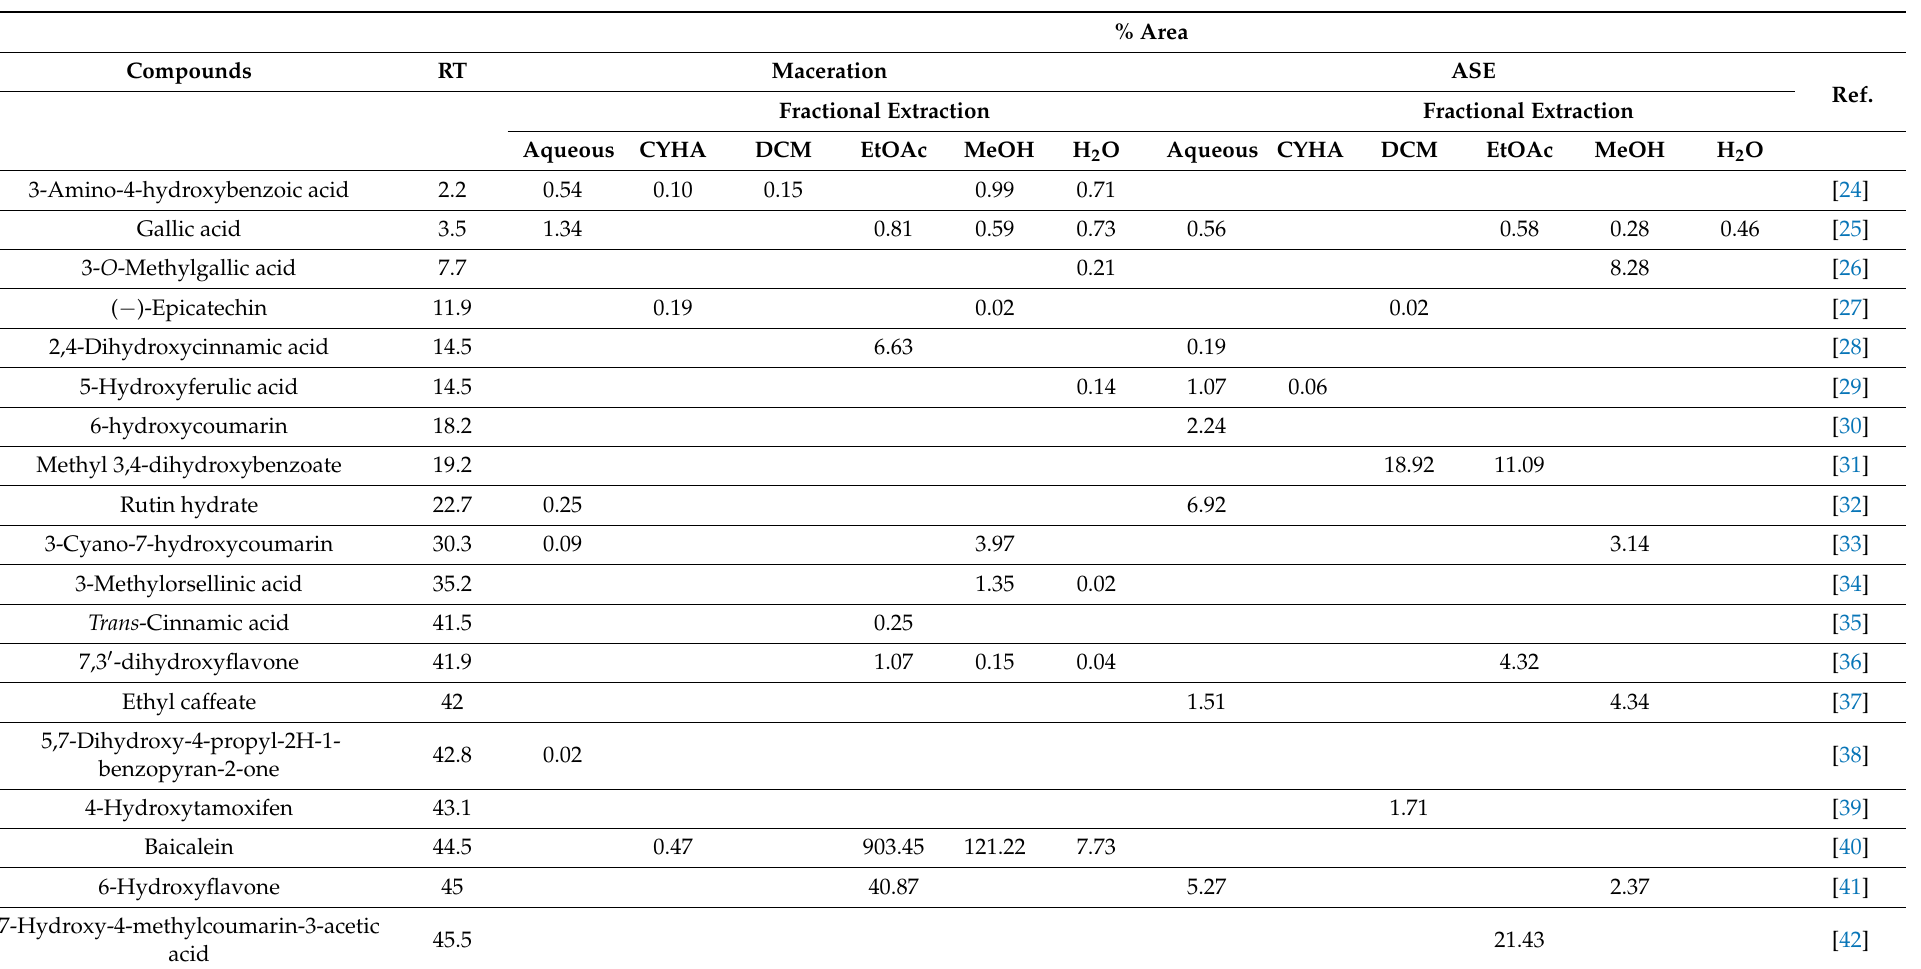
Table 3. Identification of compounds by HPLC-DAD of the grape stem extracts (A: Aqueous, C: cyclohexane, D: dichloromethane, E: ethyl acetate, M: methanol, H: H 2 O.